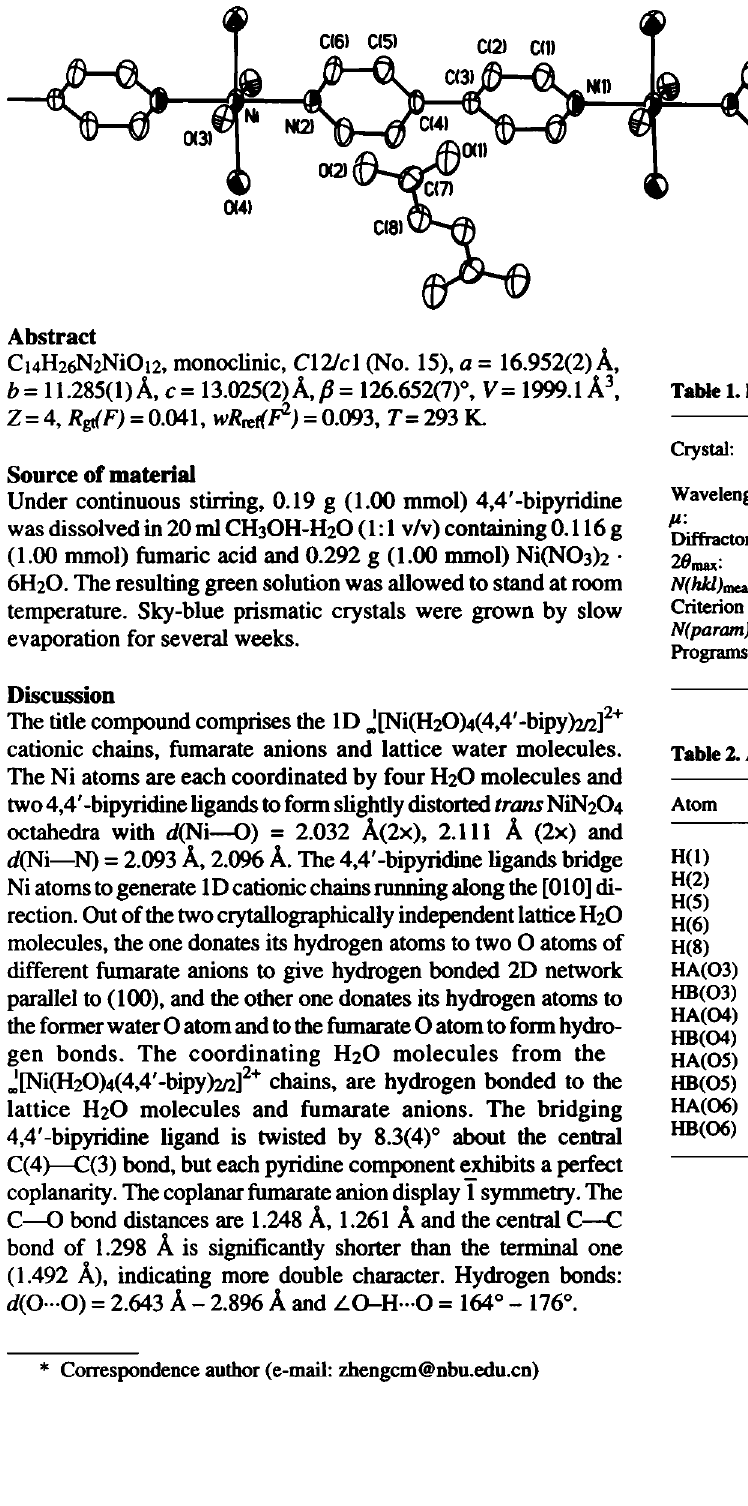
Table 1. Data collection and handling.